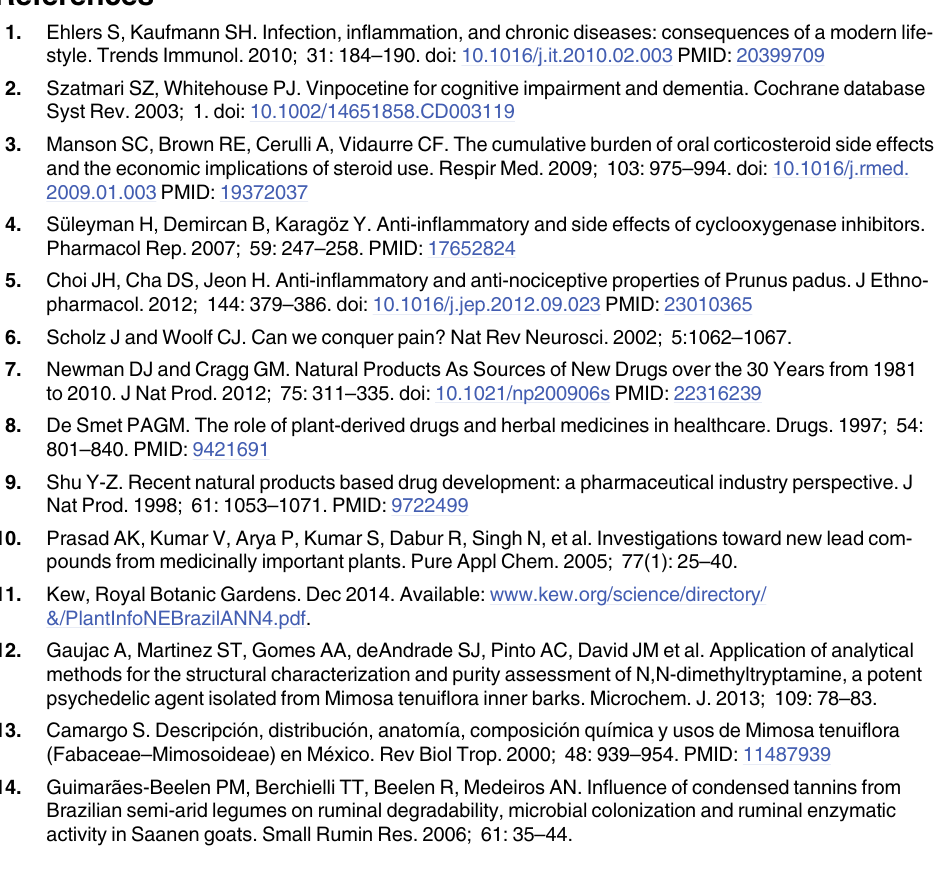
S12 Fig. Chemical structure and 1 H NMR spectral data of 5-hydroxy-7,8,4 ’ -trimethoxyfla- vonol (9) [300 MHz, CDCl , δ (ppm)]. 3 (TIF) S13 Fig. Effect of ethanol extract of M . tenuiflora bark and leaf in writhing test induced by acetic acid (0.6%) of mice pretreated with 200 mg/kg. VH are mice treated with vehicle (neg- ative control). Results are presented as means ± S.D. of writhing in mice (n = 8). Statistical sig- nificance was calculated by ANOVA followed by Bonferroni's test. (cid:3) P < 0.05 compared to the vehicle-treated group.